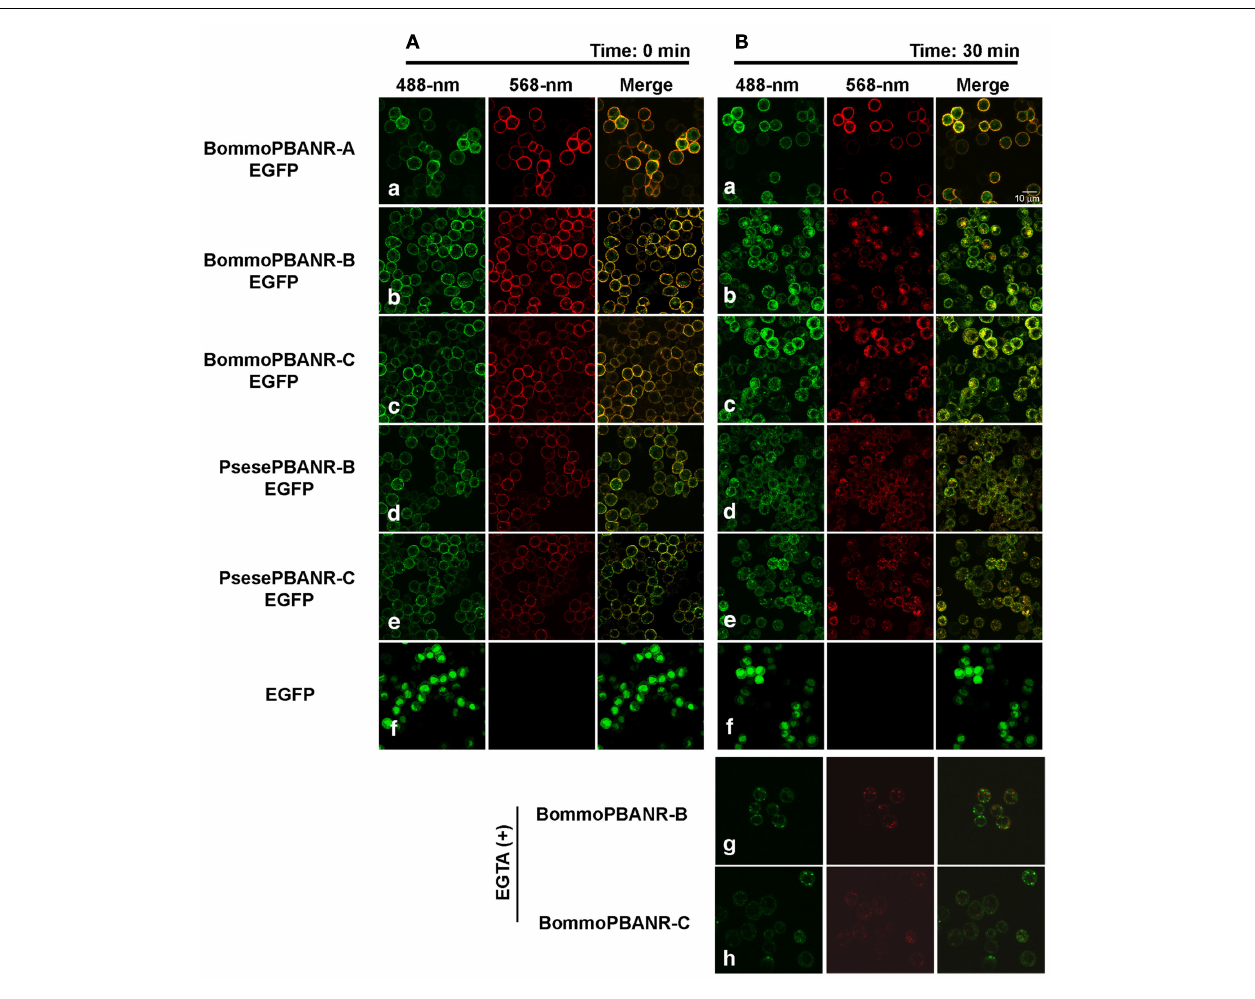
FIGURE 3 | Dynamics of EGFP-tagged PBANR variants stably expressed in Sf9 cells following binding with RR-C10PBAN R2K . (A) Confocal imaging immediately after application of 50nM RR-C10PBAN R2K . (B) Confocal imaging